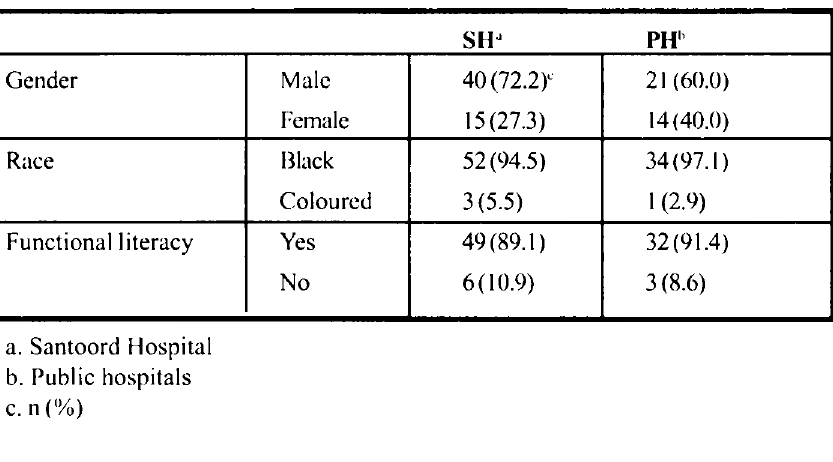
Table 1: TB hospital patients’ gender, race and functional literacy fell ill with TB, compared with the R478